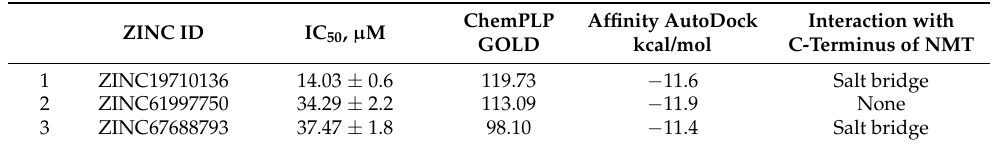
Table 2. IC 50 and docking scores of ligands identified in the virtual screening. The control NMT inhibitors are shaded in